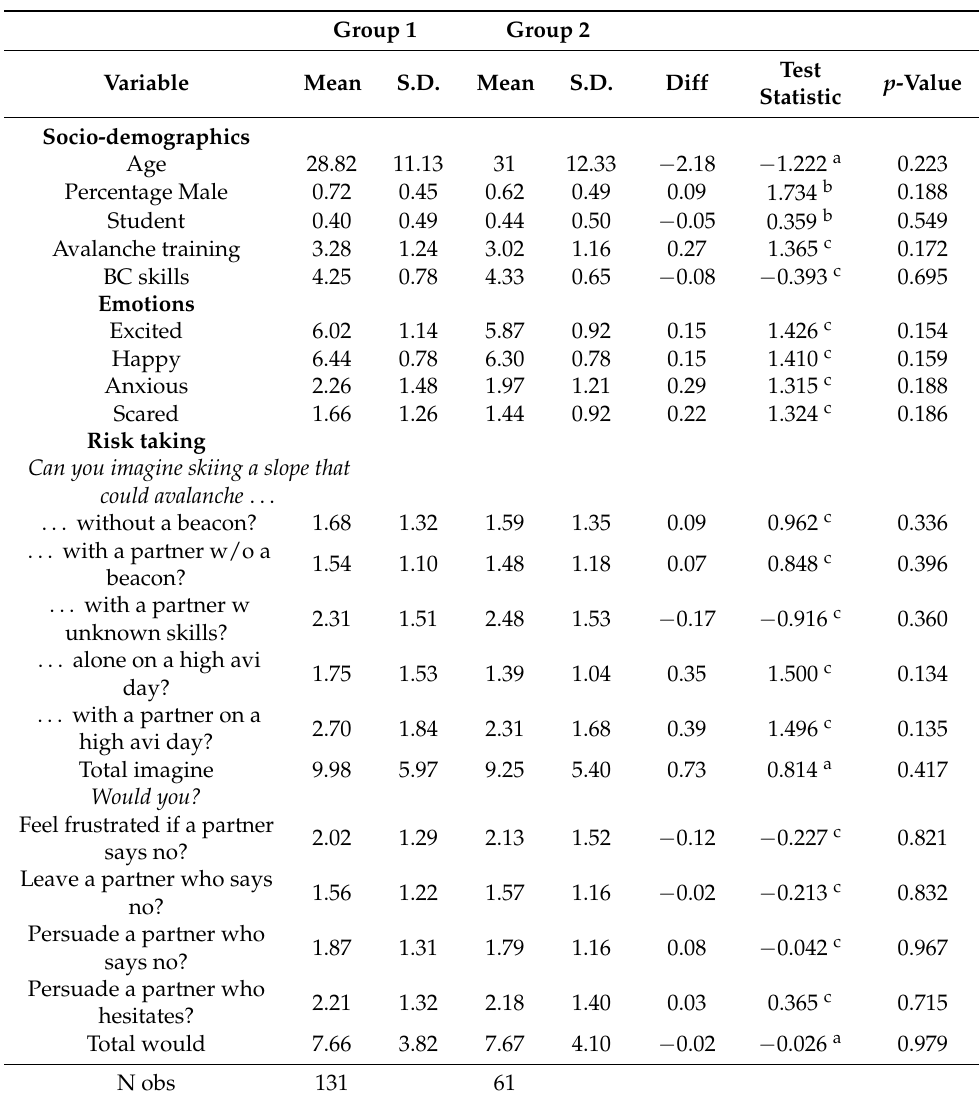
Table 7. Descriptive statistics—Group 1 (Hot) and Group 2 (Hot and